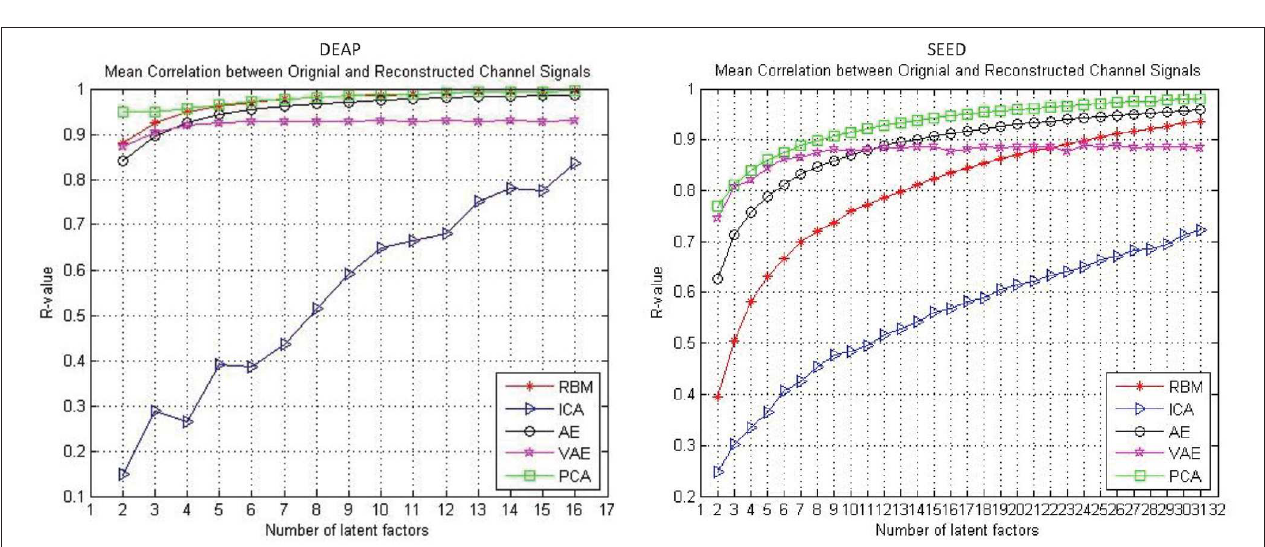
FIGURE 3 | The reconstruction performance (mean Pearson correlation coefficient) of different decoding models when assuming a different number of latent factors.